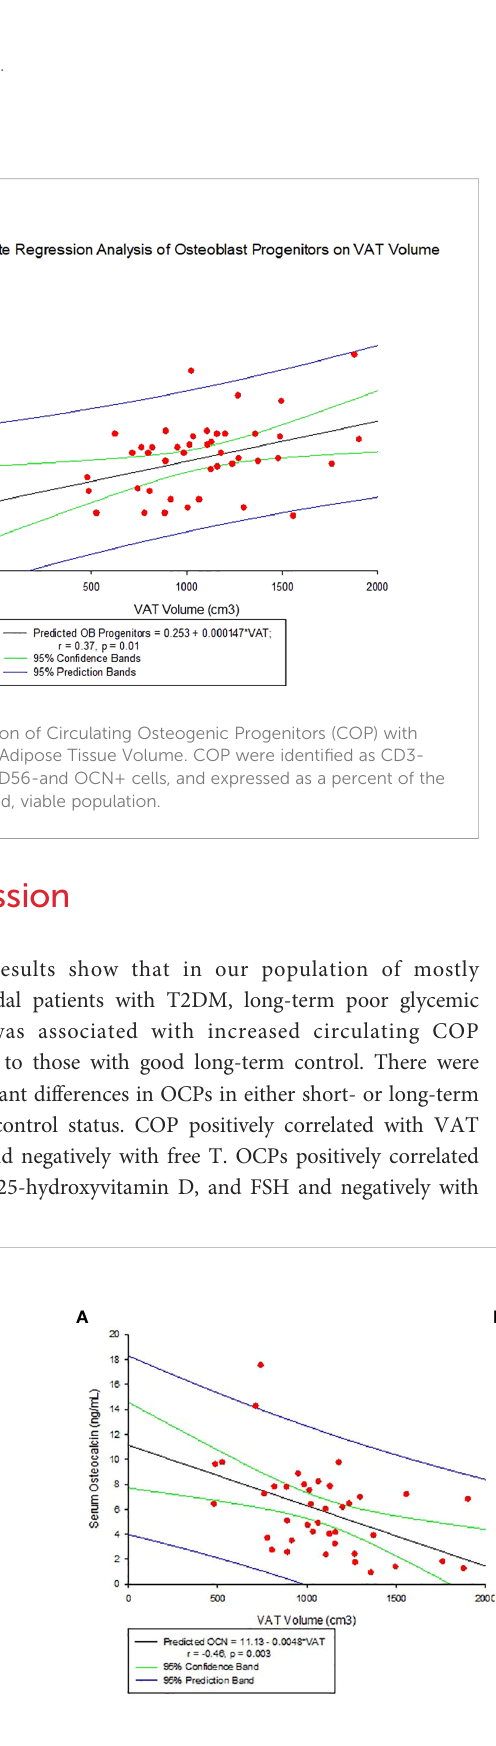
FIGURE 3 (A) Correlation between Serum Osteocalcin and Visceral Adipose Tissue Volume (VAT). (B) Correlation between Serum C-telopeptide (CTX) and Appendicular lean